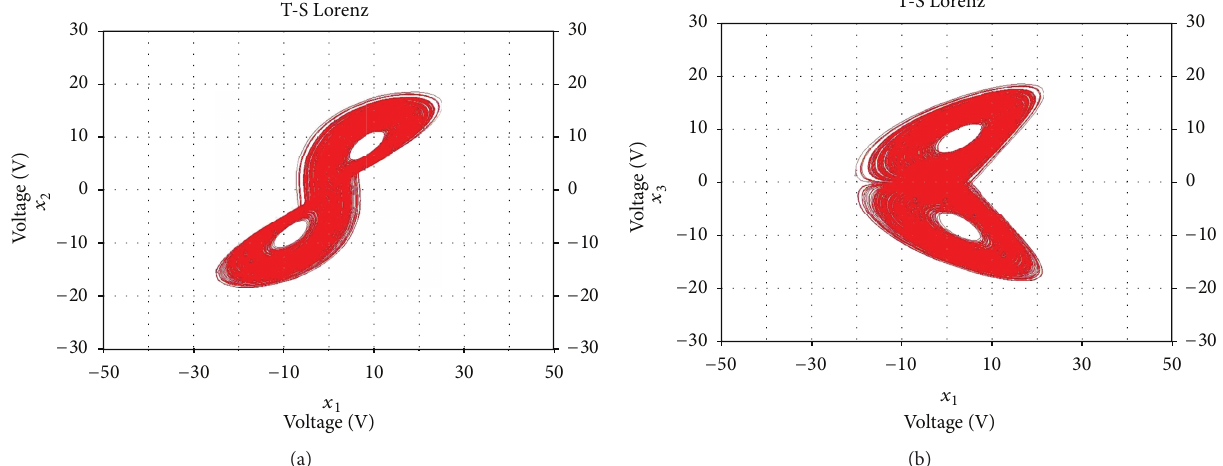
Figure 2: Projection of phase portraits outputs in fuzzy electronic circuit for the Lorenz system.